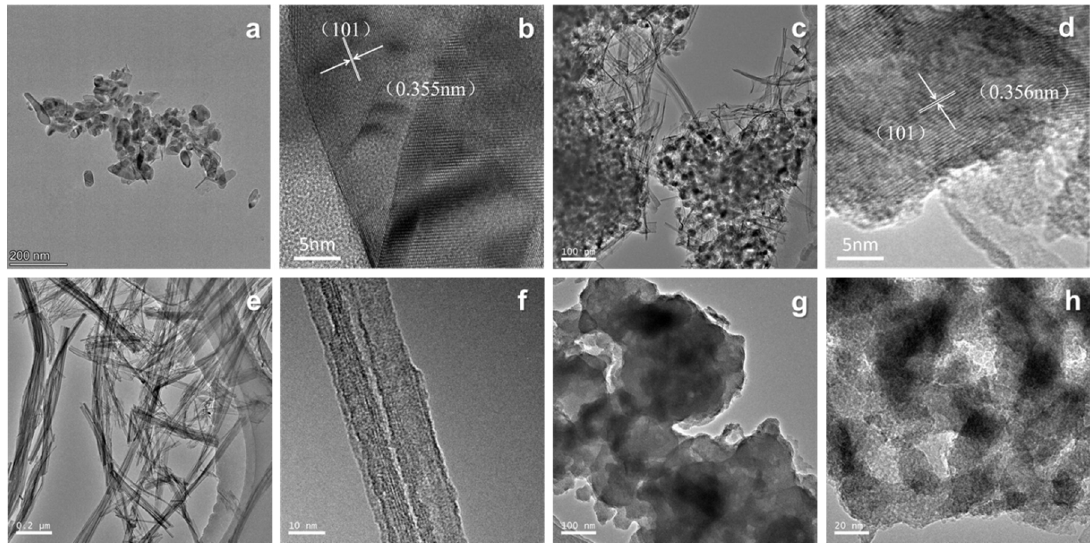
Figure 3. TEM images of catalysts originating from anatase TiO 2 with different concentrations of NaOH in hydrothermal processes: ( a , b ) for sample A-5, ( c , d ) for A-7.5, ( e , f ) for A-10, and ( g , h ) for